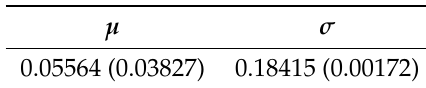
Table 1. Parameters of the GBMobtained by the MLE method with the corresponding standard errors between